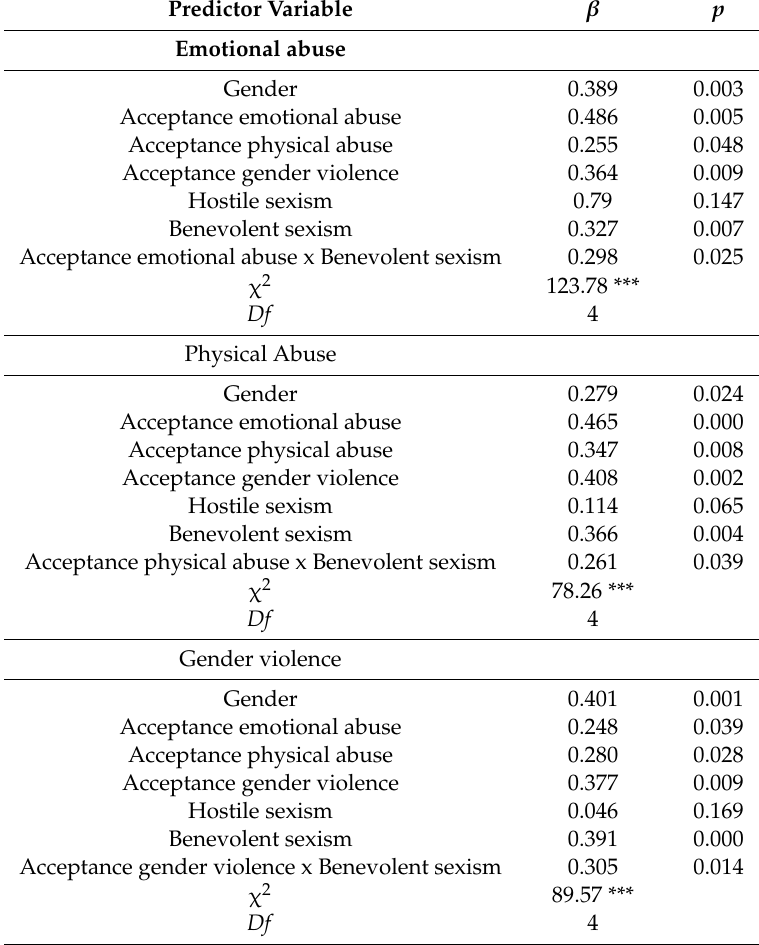
Table 3. Negative binomial regression